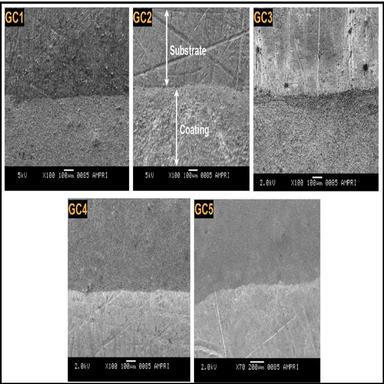
SEM micrographs for coating-substrate interface analysis for different geopolymeric mix compositions.